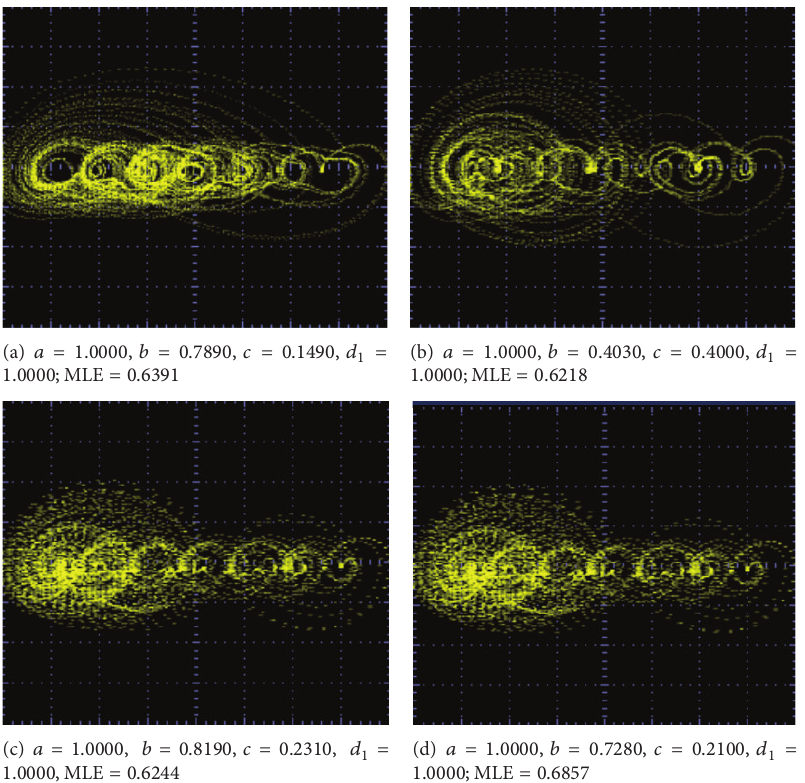
Figure 12: Optimized MLE for generating 7 scrolls.